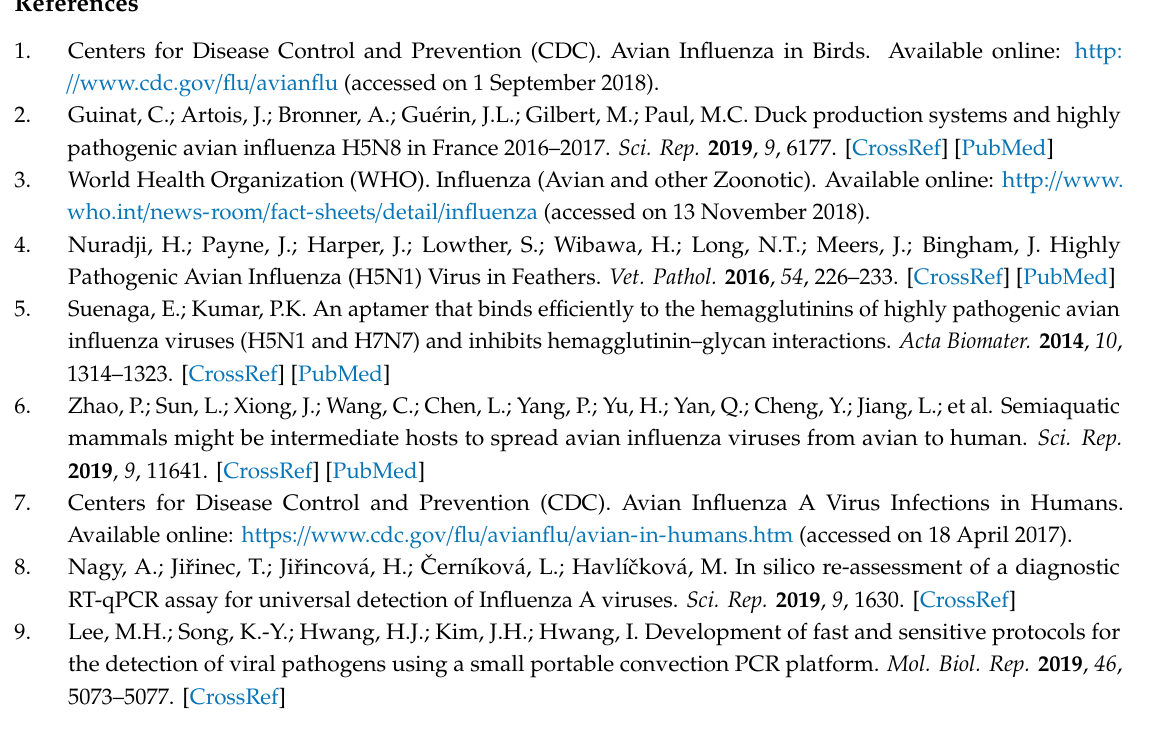
Figure S1: Schematic of SELEX method. Figure S2: Construction of ssDNA library. Figure S3: Secondary structure of aptamers. Figure S4: Optimization of the rGO concentration and reaction time. Figure S5: Characterization of truncated aptamers with the fluorescence quenching and recovery assay. Figure S6: Hemagglutination inhibition assay of influenza virus with truncated aptamers. Table S1: Experimental conditions of the